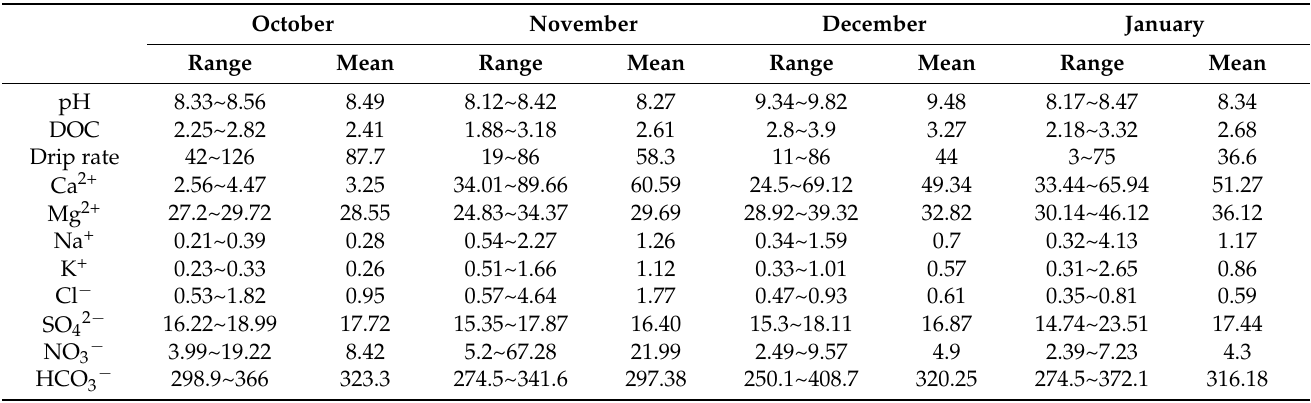
Table 1. Statistics of chemical parameters of drip water in Daxiao Cave from October 2020 to January 2021, where all units are in mg/L except for pH and Drip